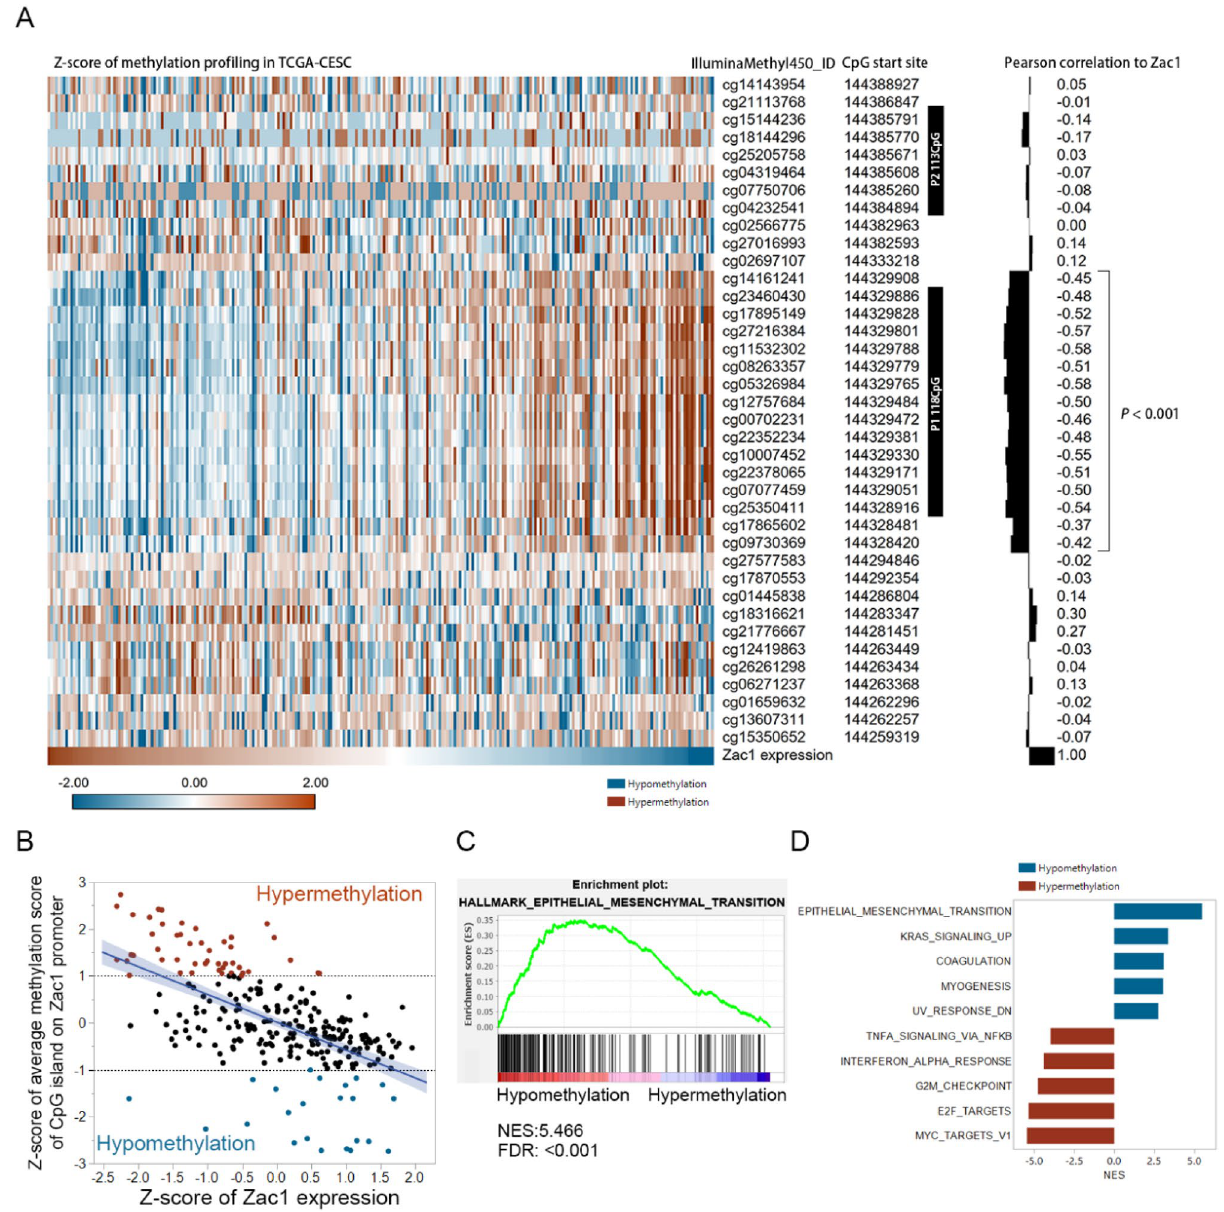
Figure 5. Methylation profiling of Zac1 promoter and correlated gene set enrichment analysis in TCGA-CESC. (A) Pearson correlation of normalized methylation score of various CpG sites on Zac1 promoter and Zac1 expression. Black boxes represent previously reported P1 and P2 CpG sites. Only P-value by Pearson correlation less than 0.001 were noted. (B) Scatter plot showing the correlation between Z-score normalized average methylation score of P1 CpG sites and Zac1 expression. Z-score of methylation profiling larger or smaller than 1 or − 1 were identified as hypermethylation (orange) or hypomethylation (blue) respectively. (C) Enrichment plot showing the top enriched hallmark gene-set associated with hypomethylation samples identified in (B) . (D) Top 5 positively or negatively enriched gene-sets acquired from the analysis of (C)